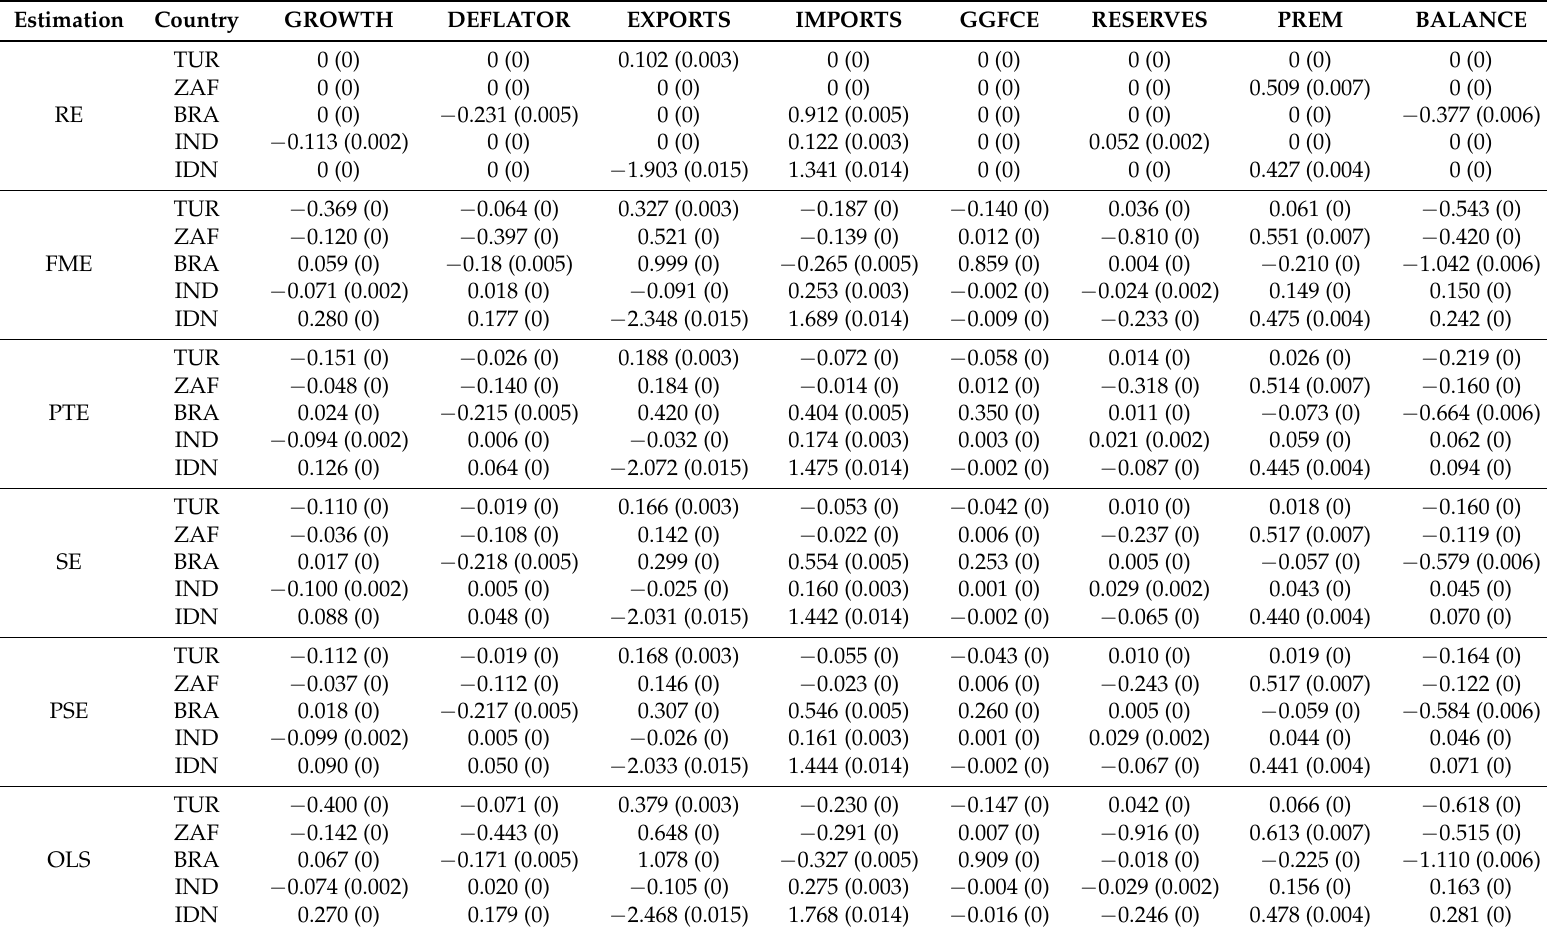
Table 13. Estimated